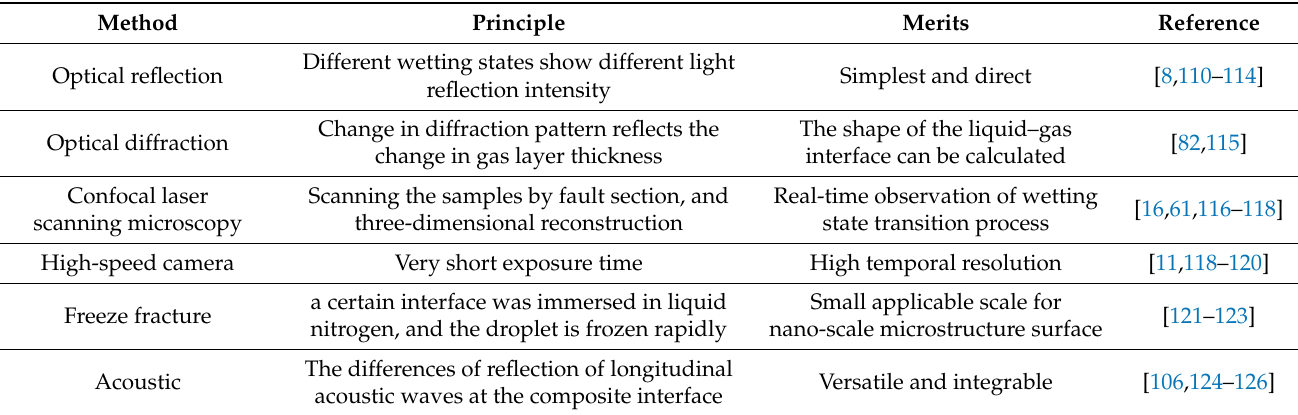
Table 1. Summary of wetting transition testing